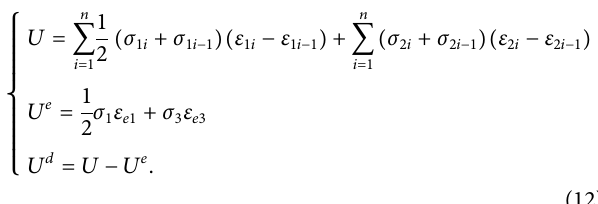
Frontiers in Earth Science |